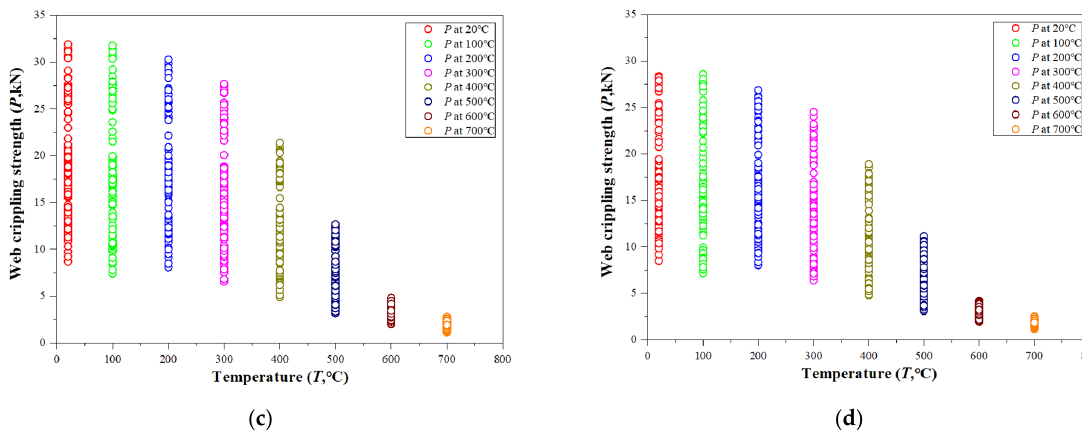
Figure 10. Web crippling strength against temperatures for cold-formed steel channel with ( a ) offset web hole and fastened flanges subjected to IOF; ( b ) offset web hole and unfastened flanges subjected to IOF; ( c ) centered web hole and fastened flanges subjected to IOF; ( d ) centered web hole and unfastened flanges subjected to IOF.